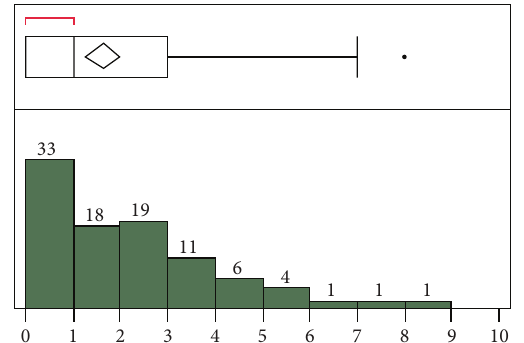
Figure 4: Validation cohort: sum of the absolute value of the difference between the automatic and manual SOFA component scores. For the outlier box plot, the first box represents the first and second quartiles, followed by the third quartile. Fourth quartile outliers are represented by black dots. The triangle represents the mean difference